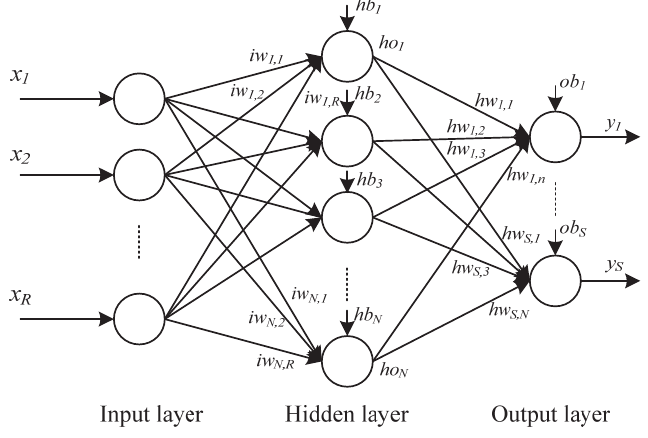
Fig. 1. A feed-forward network with three